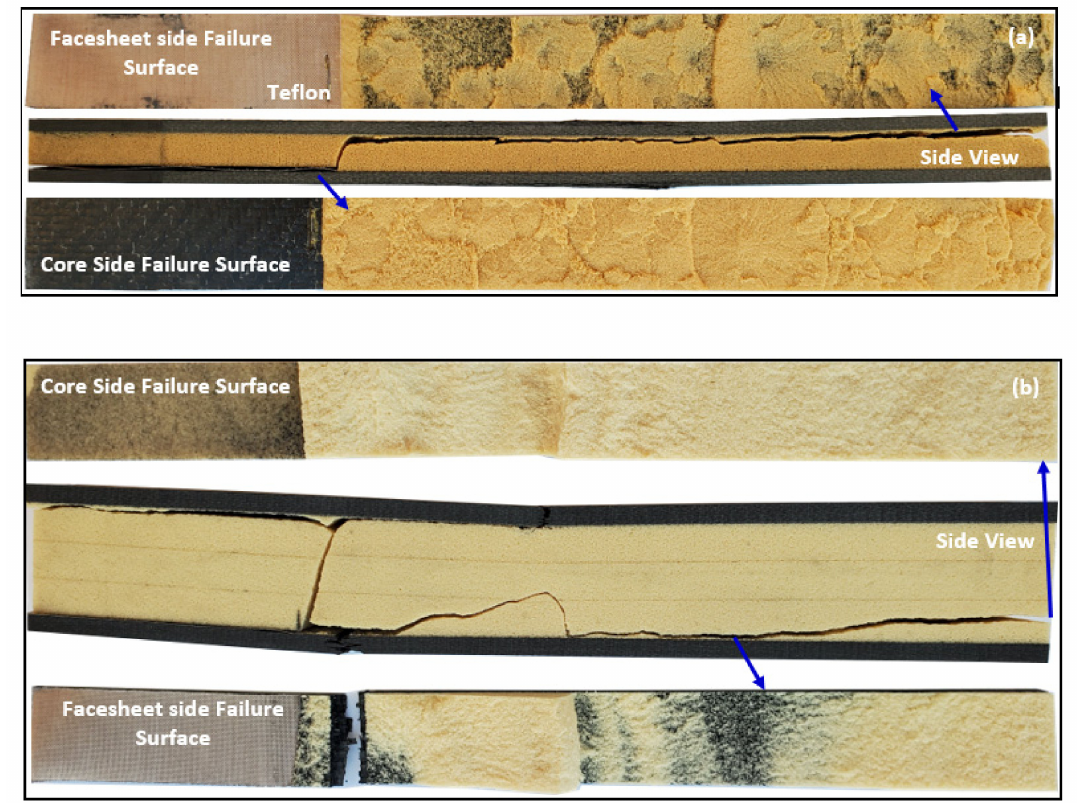
Figure 11. Failure surfaces of posted specimens ( a ): thin cored specimens; ( b ) thick cored